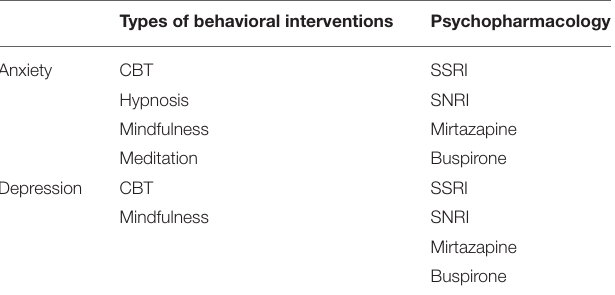
TABLE 2 | The behavioral interventions and psychopharmacology